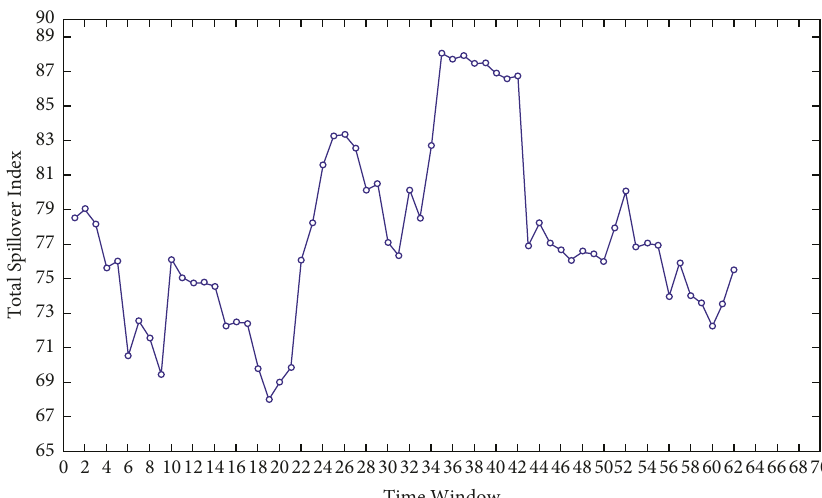
Figure 3: Total spillover index (return spillover). Note: see Figure